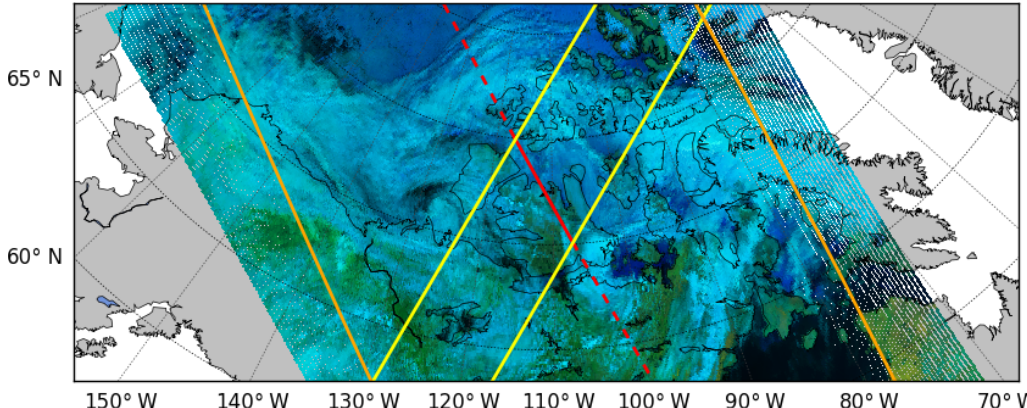
Figure 9. Study area NA1 (North America 1). Red (Ch1), green (Ch2), and blue (Ch4–Ch5) image derived from NOAA18 data resampled to 0.01 ◦ × 0.01 ◦ resolution. Date of observation is 22 July 2008, 19:15LST. Orange lines: extent of the collocated MODIS granule; yellow lines: extent of the collocated AATSR orbit; red line: CALIOP track outside (dashed) and within (solid) study area.